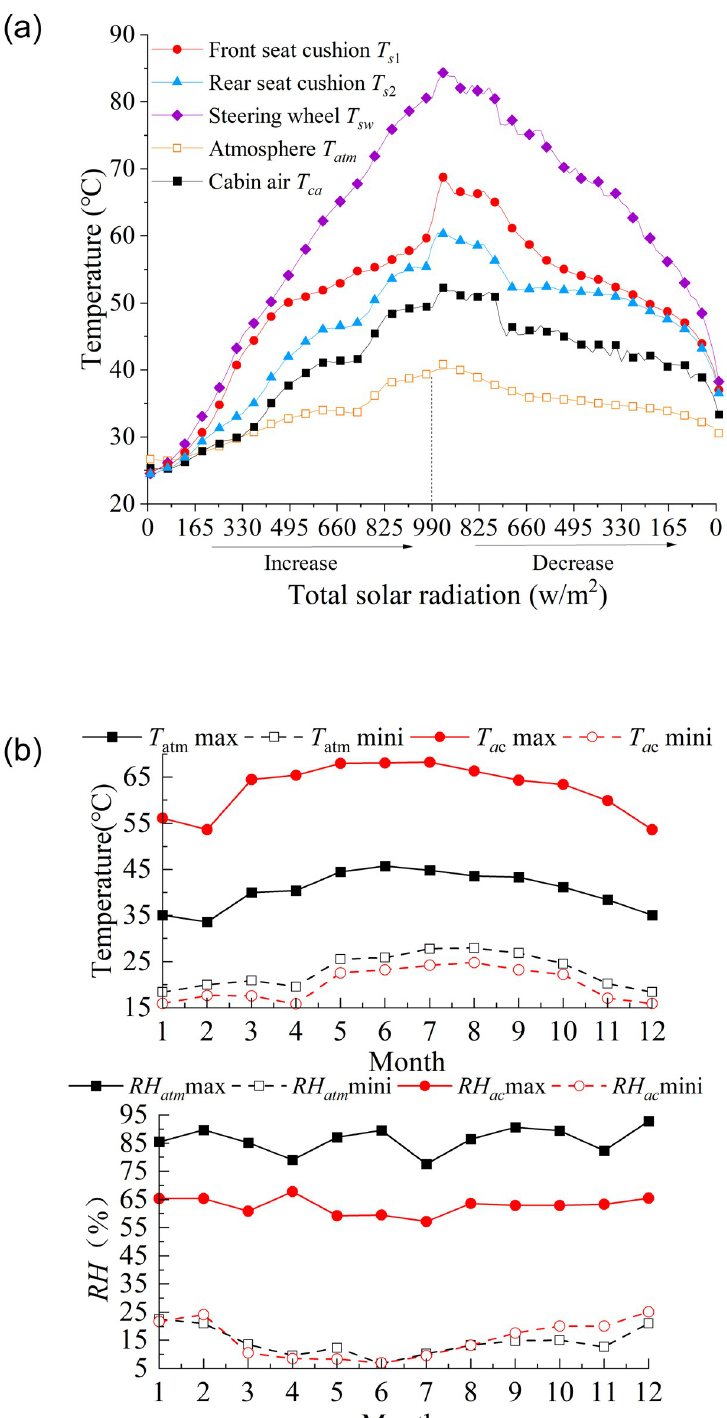
Fig 8. Thermal load of main components during parking. During the radiation increasing, the relationship between = 0.006086 I 1.117 + 25.95; cabin air, the solar radiation and the components temperature follows as: atmosphere, T atm T ca = 0.006086 I 1.117 + 25.95; the steering wheel, T Sw = 0.1161 I 0.9124 + 20.69; front seat, T s 1 = 2.475 I 4 + 0.3333 I 3 − 9.094 I 2 + 10.64 I + 50.25; rear seat, T s 2 = − 0.1648 I 2 + 10.35 I + 40.8; During the radiation decreasing, the correlation follows as: 2 2 atmosphere T ¼ 11 : 41 e (cid:0) I (cid:0) 1 : 879 0 : 9813 ð Þ þ 35 : 09 e (cid:0) I þ 0 : 1619 4 : 424 ð Þ ; steering wheel T Sw = 1.739 I 0.4881 + 33.89; front seat T s 1 atm